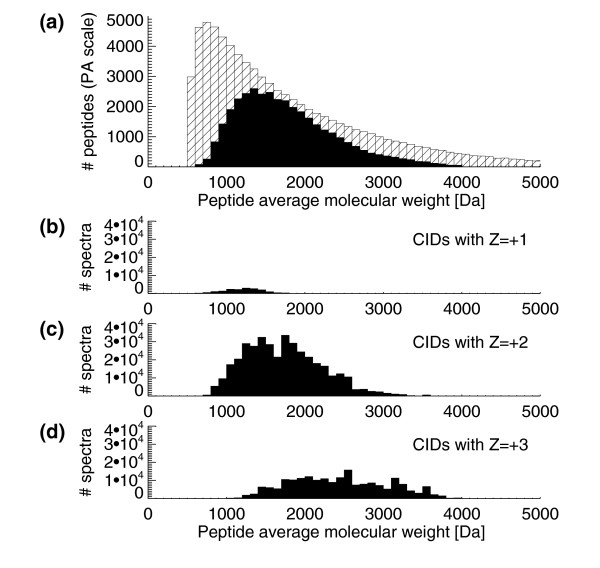
Mass histograms. (a) Average molecular weight of unique peptide sequences in PeptideAtlas (solid filled bars) and the in silico tryptically digested SGD protein database (hashed bars) allowing one missed cleavage. (b-d) Mass histograms of spectra, separated by charge. The large number of peptides with masses less than 1,000 Da are difficult to identify in database searches, and hence are not present in the PeptideAtlas. CID, collision-induced dissociation.